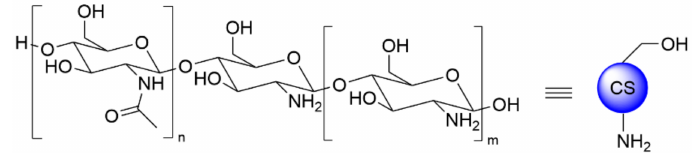
Figure 1. CS structure and schematic